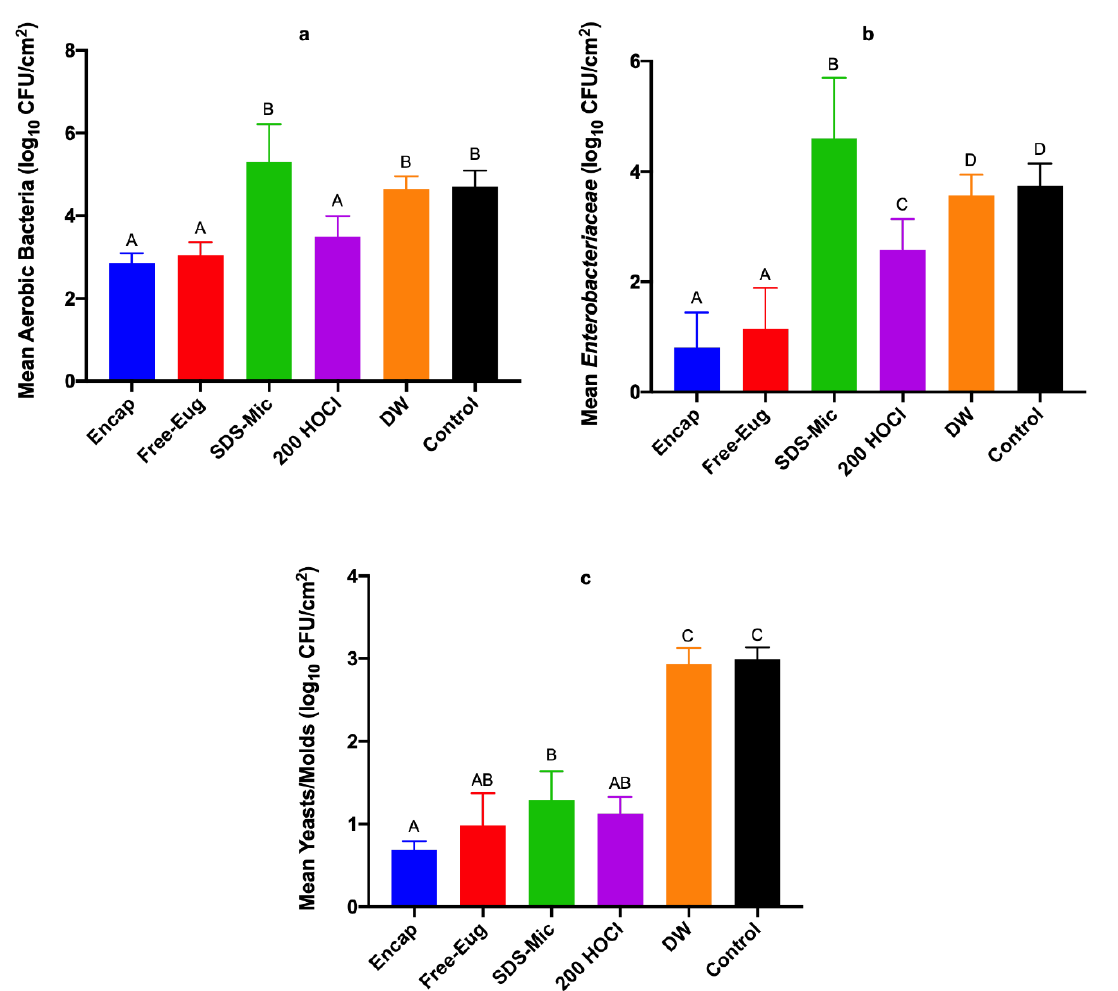
Figure 1. Means of naturally occurring microorganisms on spinach samples as function of antimicrobial treatment: ( a ) aerobic bacteria, ( b ) Enterobacteriaceae , and ( c ) yeasts and molds ( p < 0.0001). Treatments were: 1.0% sodium dodecyl sulfate (SDS) micelles loaded with 1.0% eugenol (Encap); 1.0% unencapsulated eugenol (Free-Eug); 1.0% SDS micelles unloaded (SDS-Mic); 200 ppm pH 7.0 free chlorine (200 HOCl); sterile distilled water (DW); no treatment, non-inoculated (Control). Bars depict arithmetic means from three identical replications with duplicate independent samples per replicate ( n = 6); error bars depict one sample standard deviation from the mean. Columns not sharing capitalized letters (A, B, C, D) differ at p = 0.05.